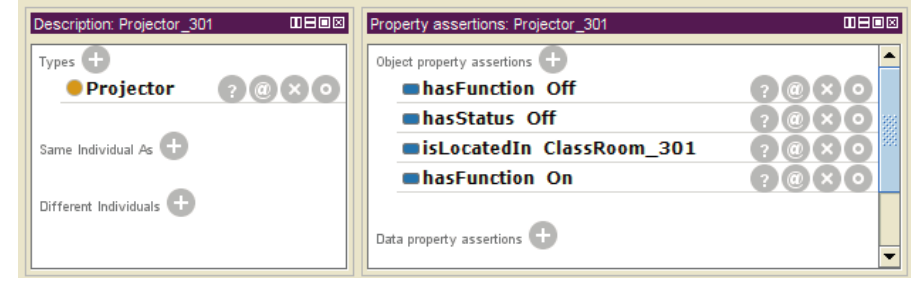
Figure 20. Actuator instance example, Projector_301 .